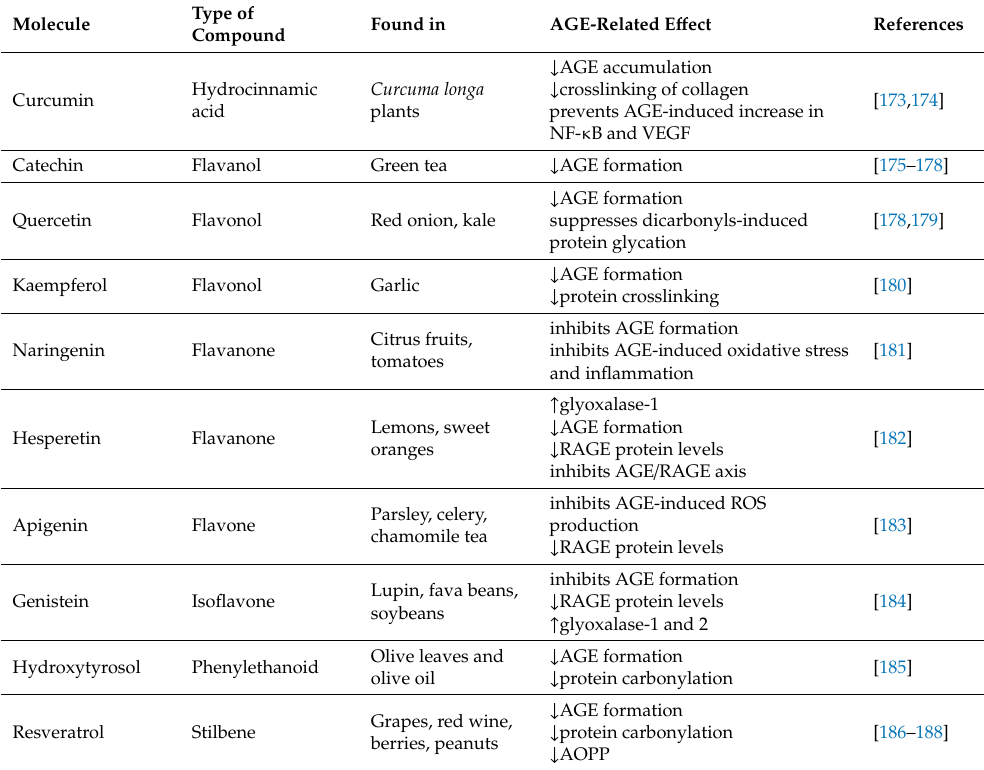
Table 1. List of some of the natural antioxidant compounds that have been used in the AGE field and the AGE-related e ff ect that they